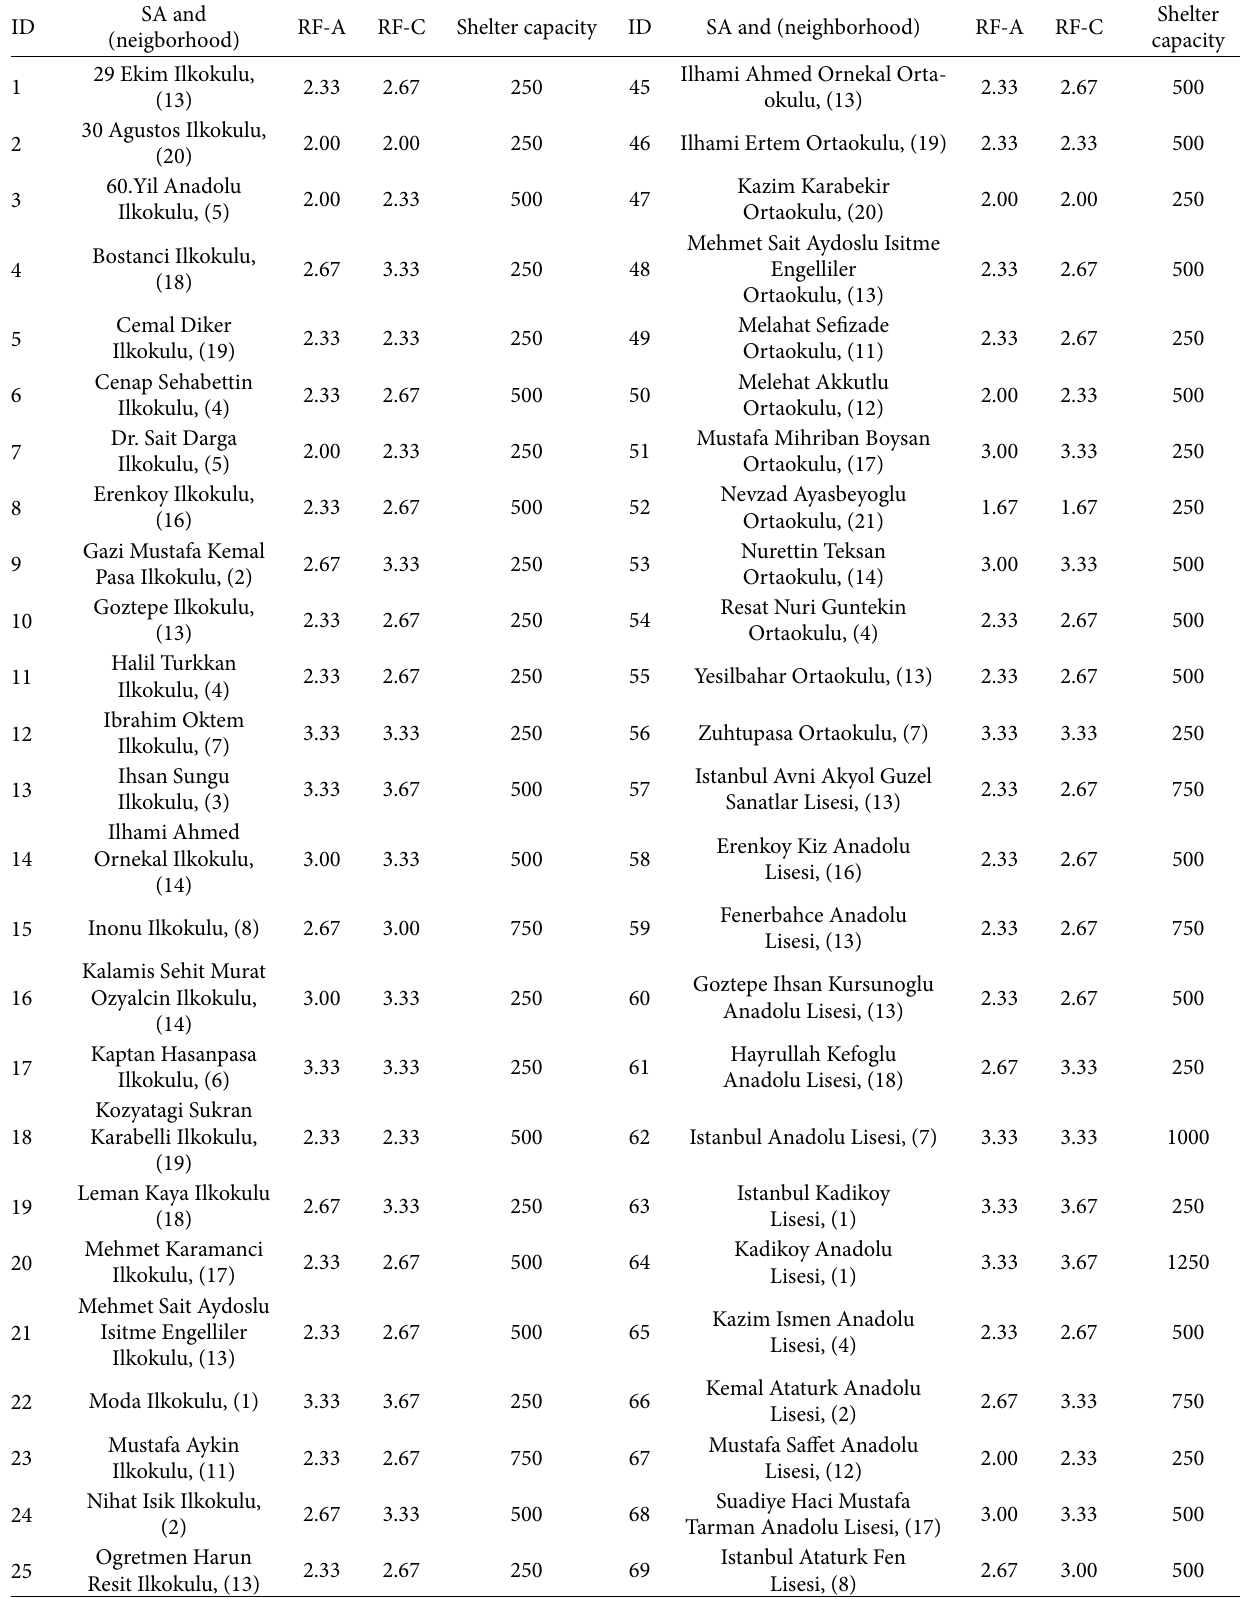
Table 4: Earthquake damage risk factors (RF) of storage areas (SA) based on model A (RF-A) and model C (RF-C) and shelter capacities in